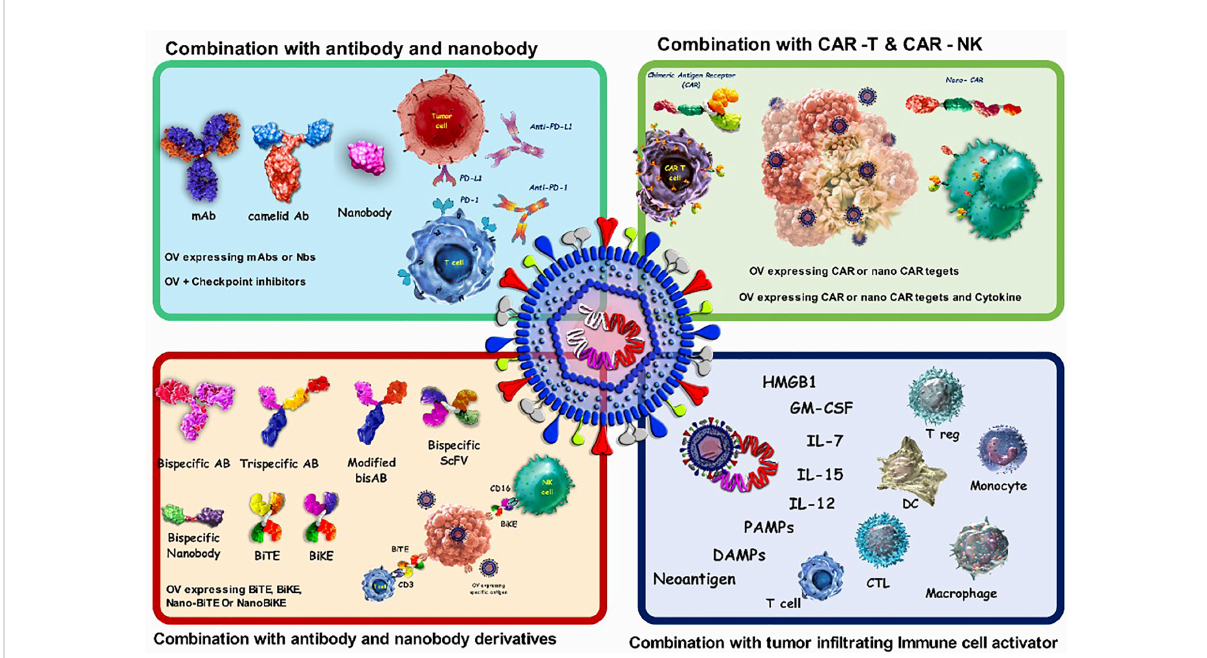
FIGURE 3 Characteristics of oncolytic virus combination therapy. OVs attack and destroy tumor cells preferentially. Lysis of tumor cells releases neoantigen, PAMPs which trigger PRRs, which then produce in fl ammatory cytokines and antiviral type I IFNs. Viruses can activate cell death pathways, resulting in immunogenic cell death phenotypes such as necroptosis, pyroptosis, immunogenic apoptosis, and autophagic cell death. Antibodies that target cell surface indicators of immune cells (checkpoint inhibition), cancer cells (targeted therapy), or both (bispeci fi c antibodies) are wellestablished in cancer therapy. combination of oncolytic viruses with antibody and CAR-T cells; CAR-T cells bind to the antigen on the surface of tumor cells and kill them, but they cannot migrate deeper into the dense tumor mass to remove antigennegative tumor cells. also, CAR-NK cells show more anticancer activity than CAR-T cells because they attach to stress ligands on the surface of tumor cells. The oncolytic virus attacks and destroys tumor cells, eliminating the tumor's dense